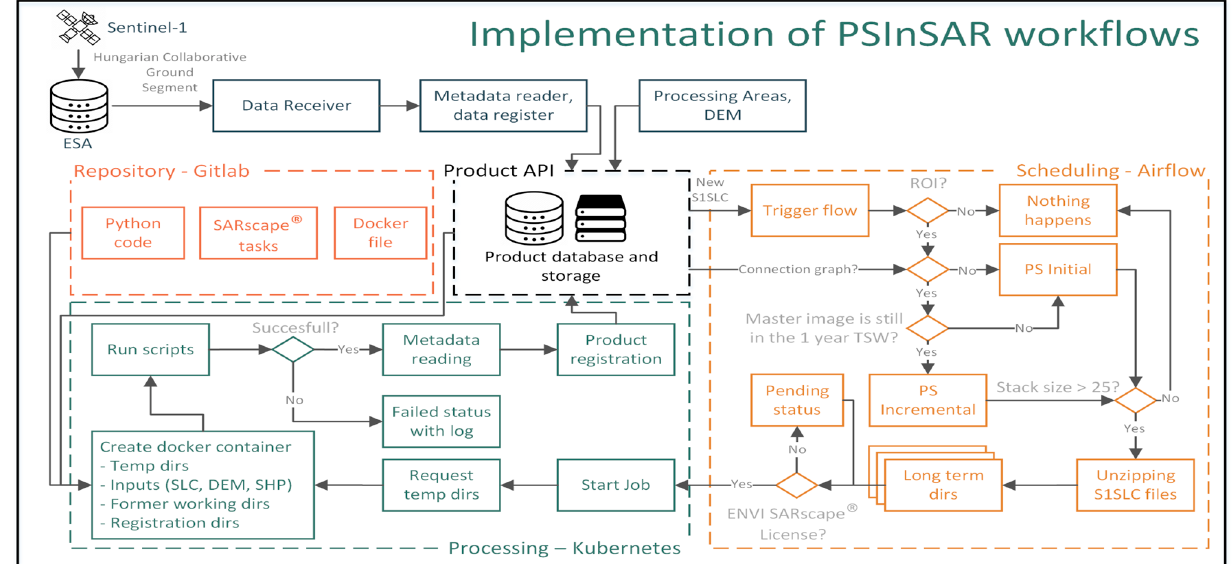
Figure 2. InSAR processing pipeline of the FIR.